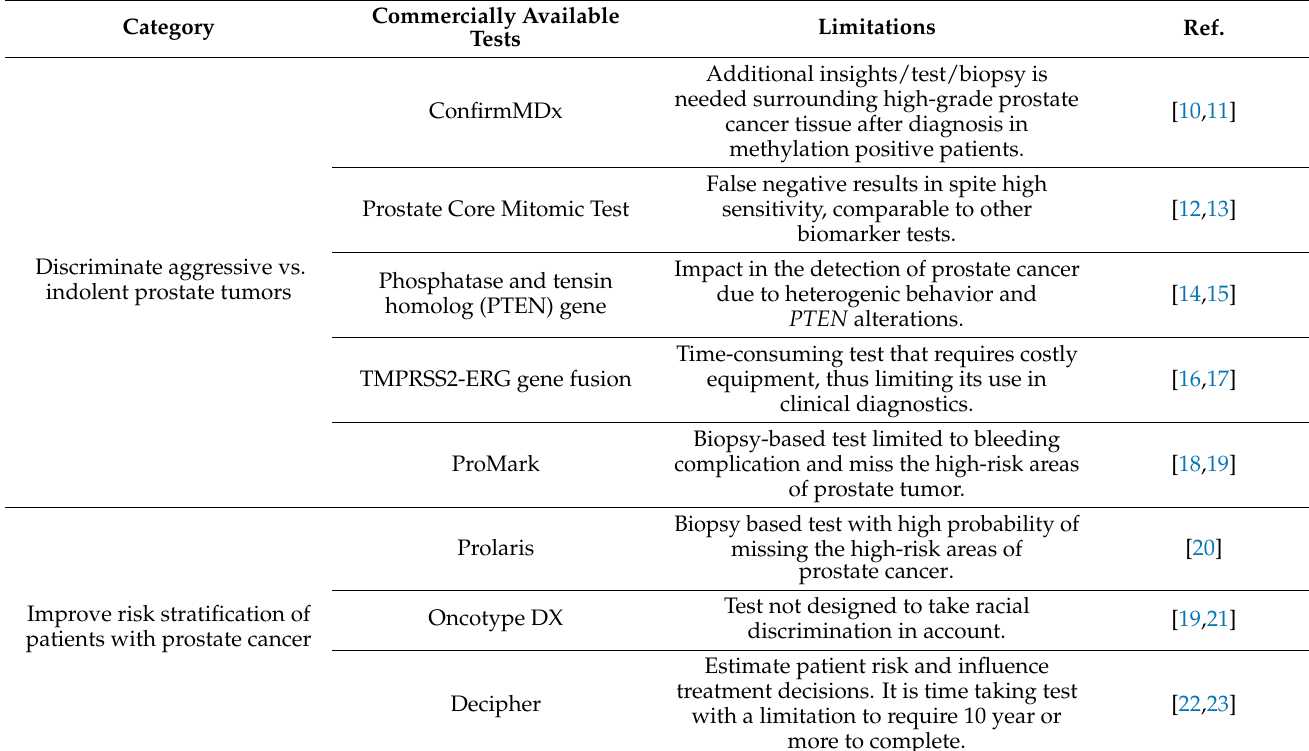
Table 1. Commercially available prognostic biomarkers in prostate